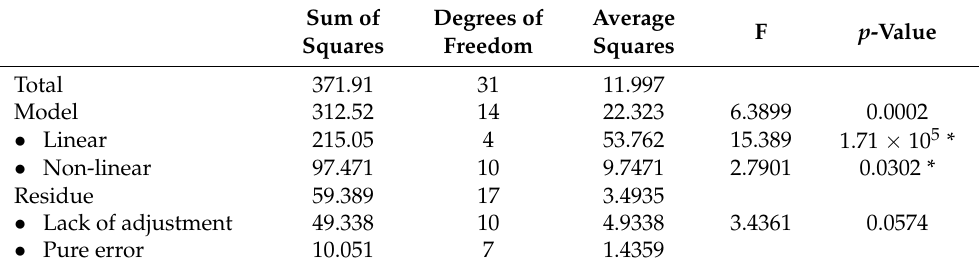
Table 4. Analysis of variance (ANOVA) of the adsorption percentage of Congo red dye in the cocoa bean shell powder. Total 371.91